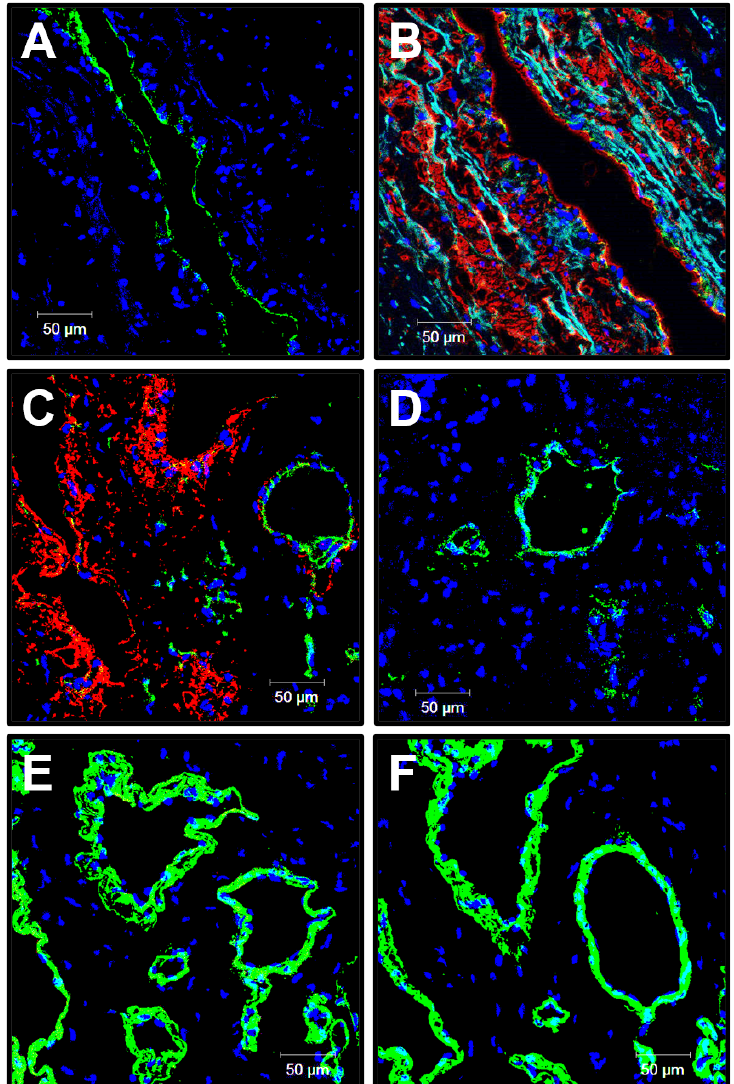
Figure 4. Confocal microscopy examination of the PHBV/PCL[VEGF-bFGF-SDF] Hep/Ilo graft 6 months postimplantation. ( A ) CD31 (a marker of endothelial cells, green colour) staining; ( B ) α - SMA (a marker of VSMCs, red colour) staining; ( C ) Combined CD31 (green colour) and-SMA (red colour) staining of the vasa vasorum within the graft; ( D ) vWF (a marker of endothelial cells and a component of the subendothelial ECM, green colour) staining of the vasa vasorum within the graft; ( E ) Type IV collagen (an ECM protein constituting the vascular basement membrane, green colour) staining; ( F ) Type III collagen (an ECM protein constituting the vascular basement membrane, green colour) staining. 4 (cid:48) ,6-diamidino-2-phenylindole (DAPI) counterstaining (nuclei, blue colour). Representative images, × 200